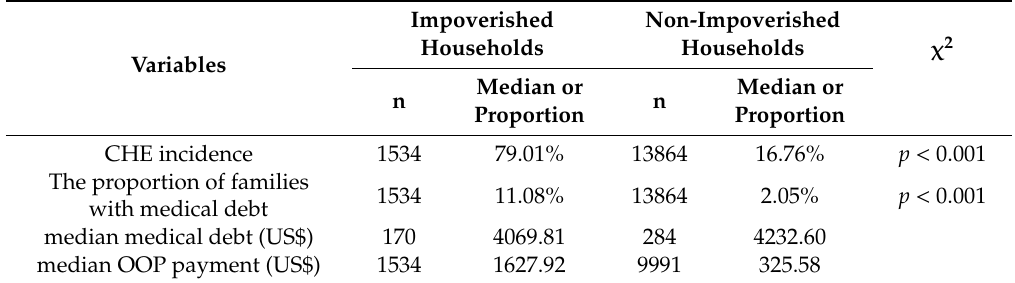
Table 3. Medical Financial Burden among Impoverished and Non-Impoverished Households.